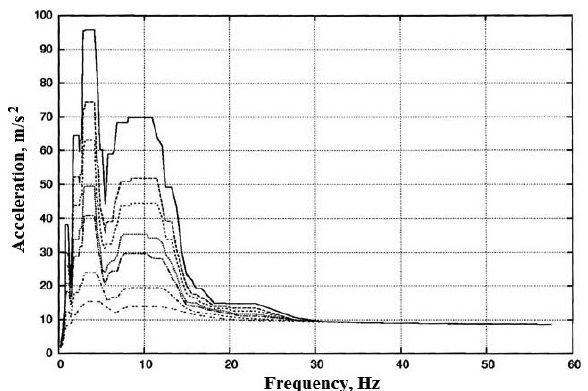
Figure 2. Designed spectrum of seismic impact. Vertical component.